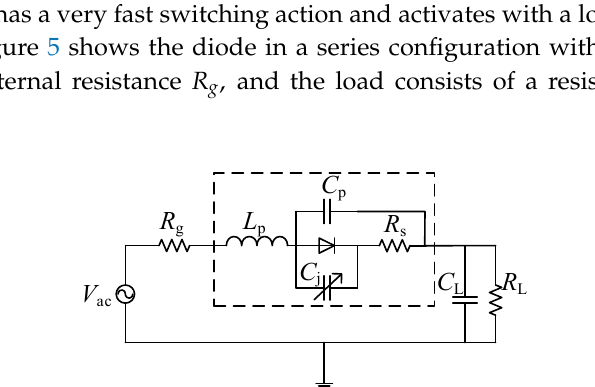
Table 2. The parameters of Schottky diode.